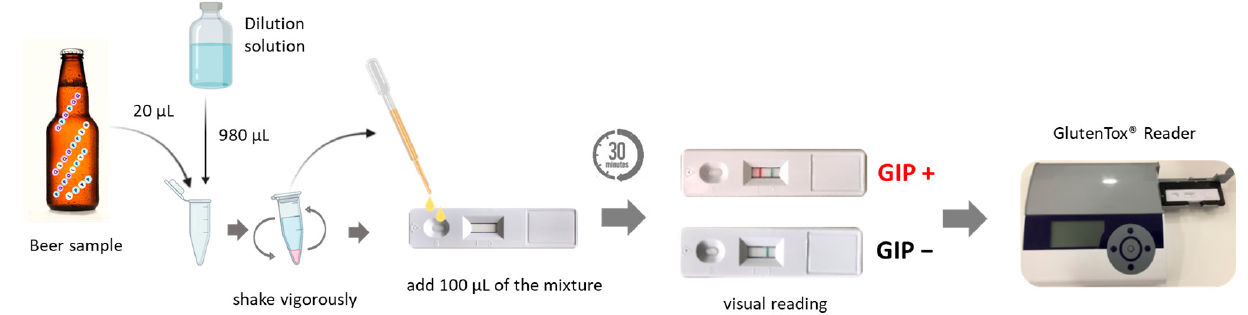
Figure 1. Working procedure for gluten analysis in beer samples. GIP, gluten immunogenic peptides; LFIA, lateral flow immunochromatographic assays.